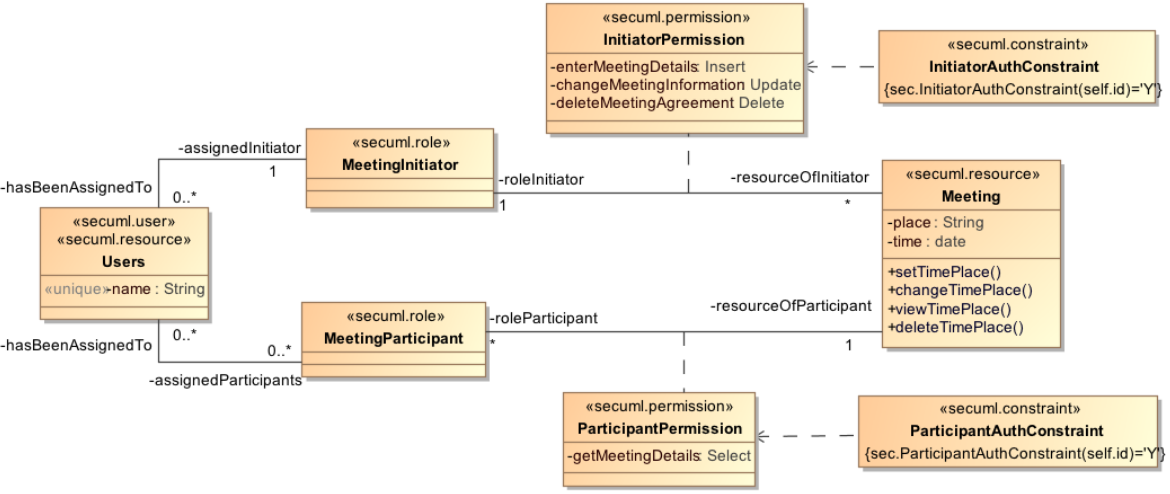
Figure 10. Meeting Scheduler Security Model